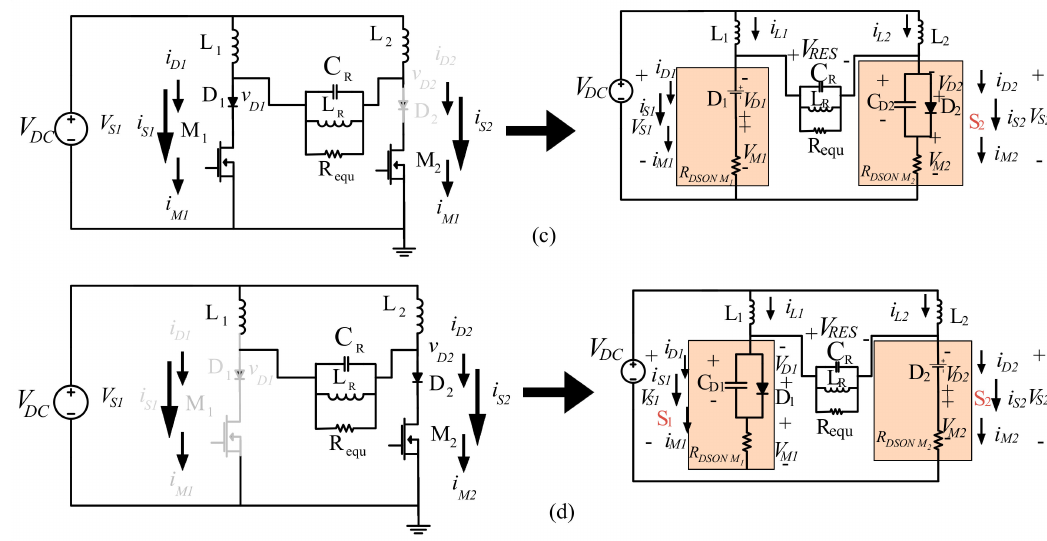
Figure 4. Equivalent circuits; ( a ) from t 0 – t 1 , ( b ) from t 1 – t 2 , ( c ) from t 2 – t 3 , ( d ) from t 3 – t 4 .